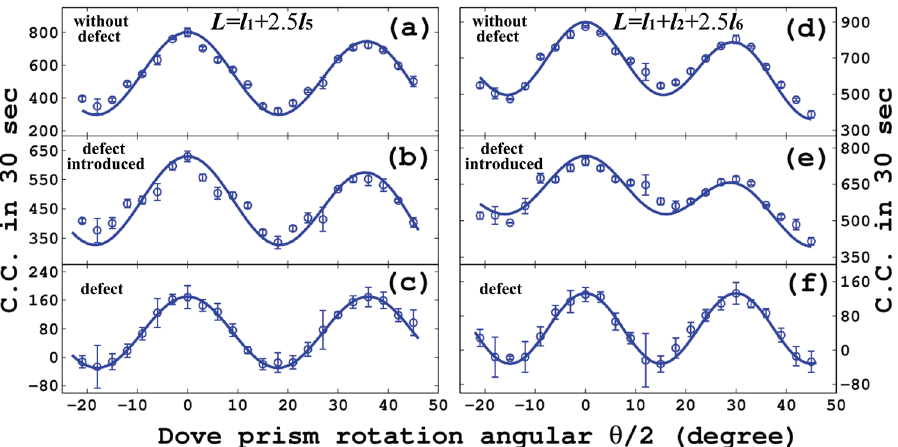
and l . ( a ) Is the result when l and l are both 7 8 7 8 is broken. ( c ) Shows the difference 8 is broken. ( f ) Shows the difference between ( a ) 2